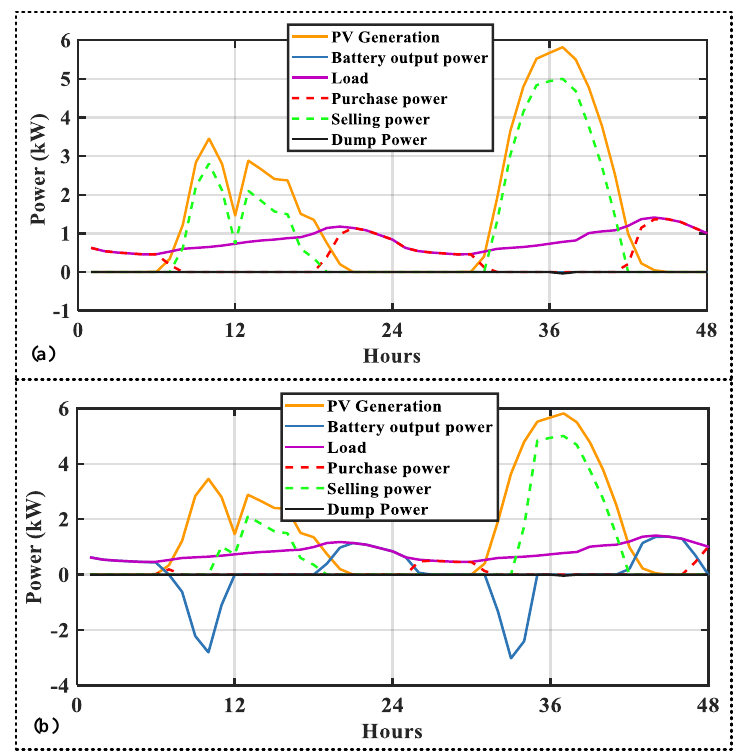
Figure 8. Daily power flow for two sample days in winter using Option 2: ( a ) PV only system; ( b ) PV-BESS system.